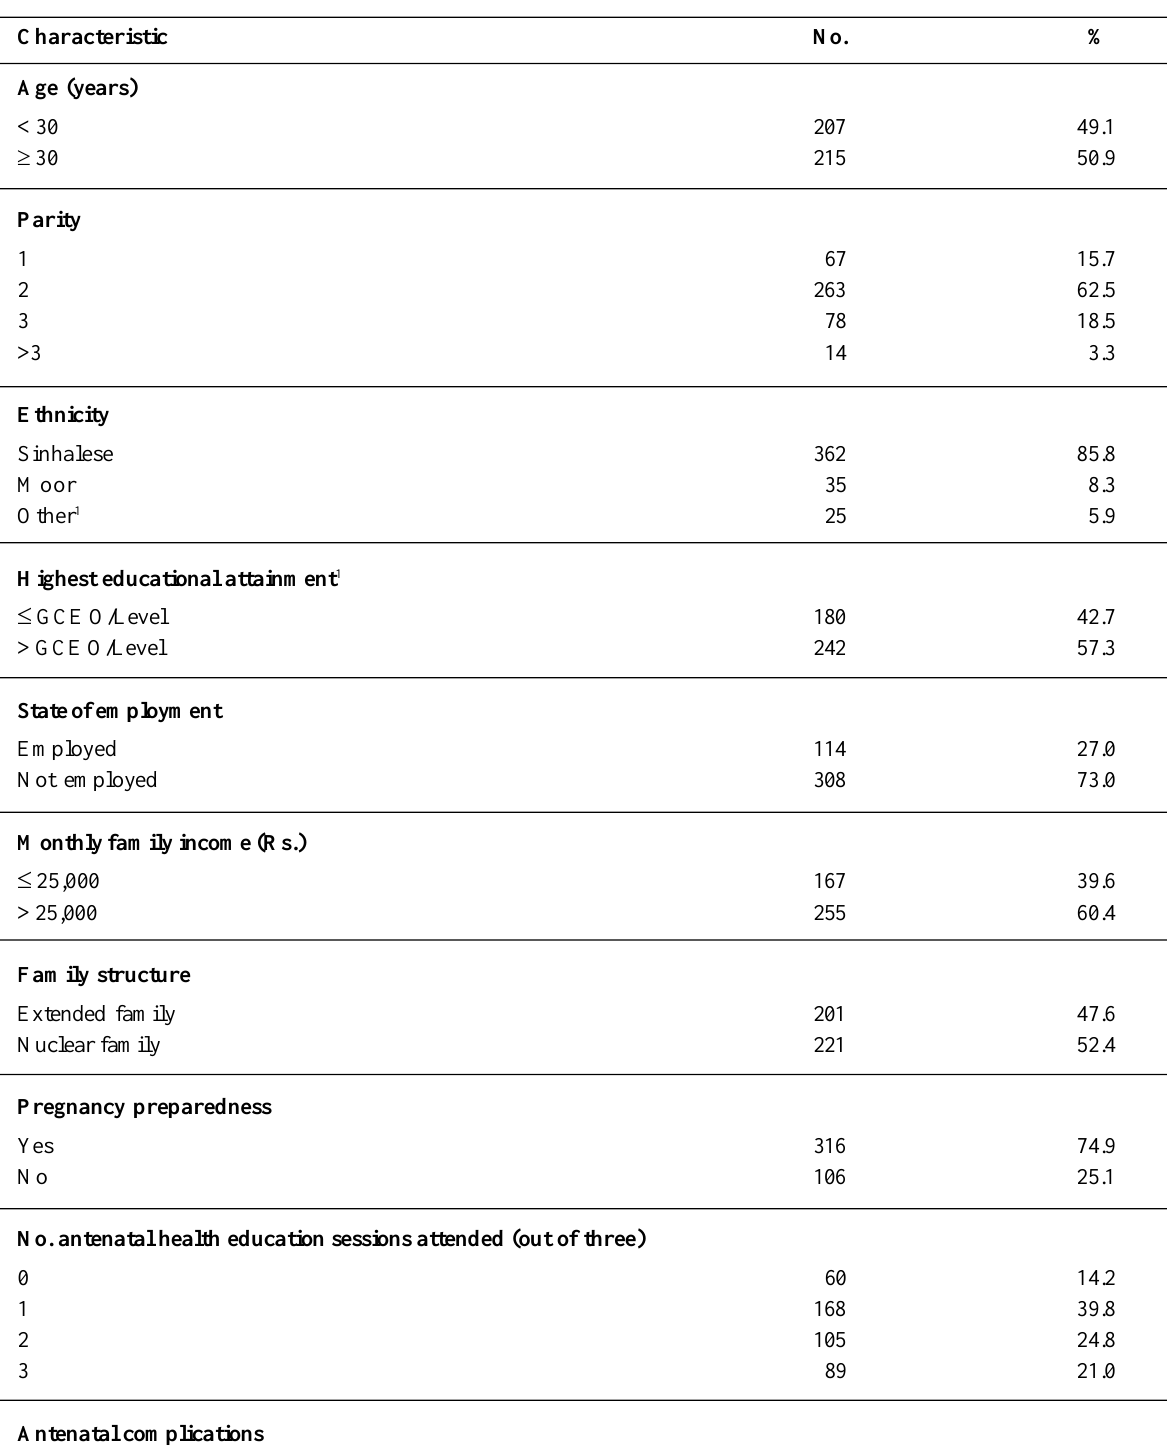
Table 1. Basic socio-demographic and pregnancy related characteristics of the study sample